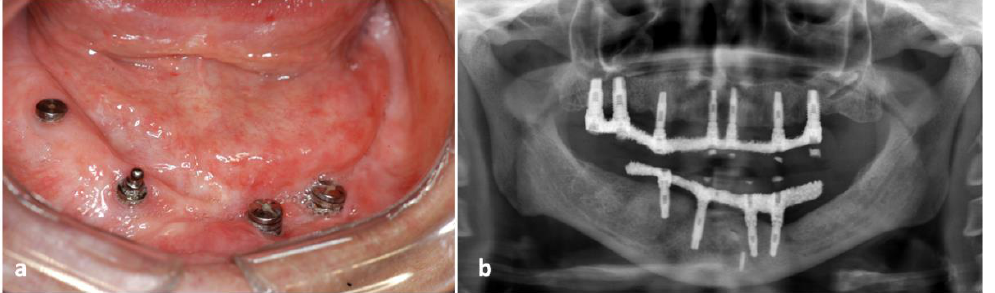
Figure 3. Clinical condition with 10 years of follow-up ( a ) and radiographic aspects after 15 years of follow-up ( b ). Clinical and radiographic features showing no evidence of recurrence or disease relapse.